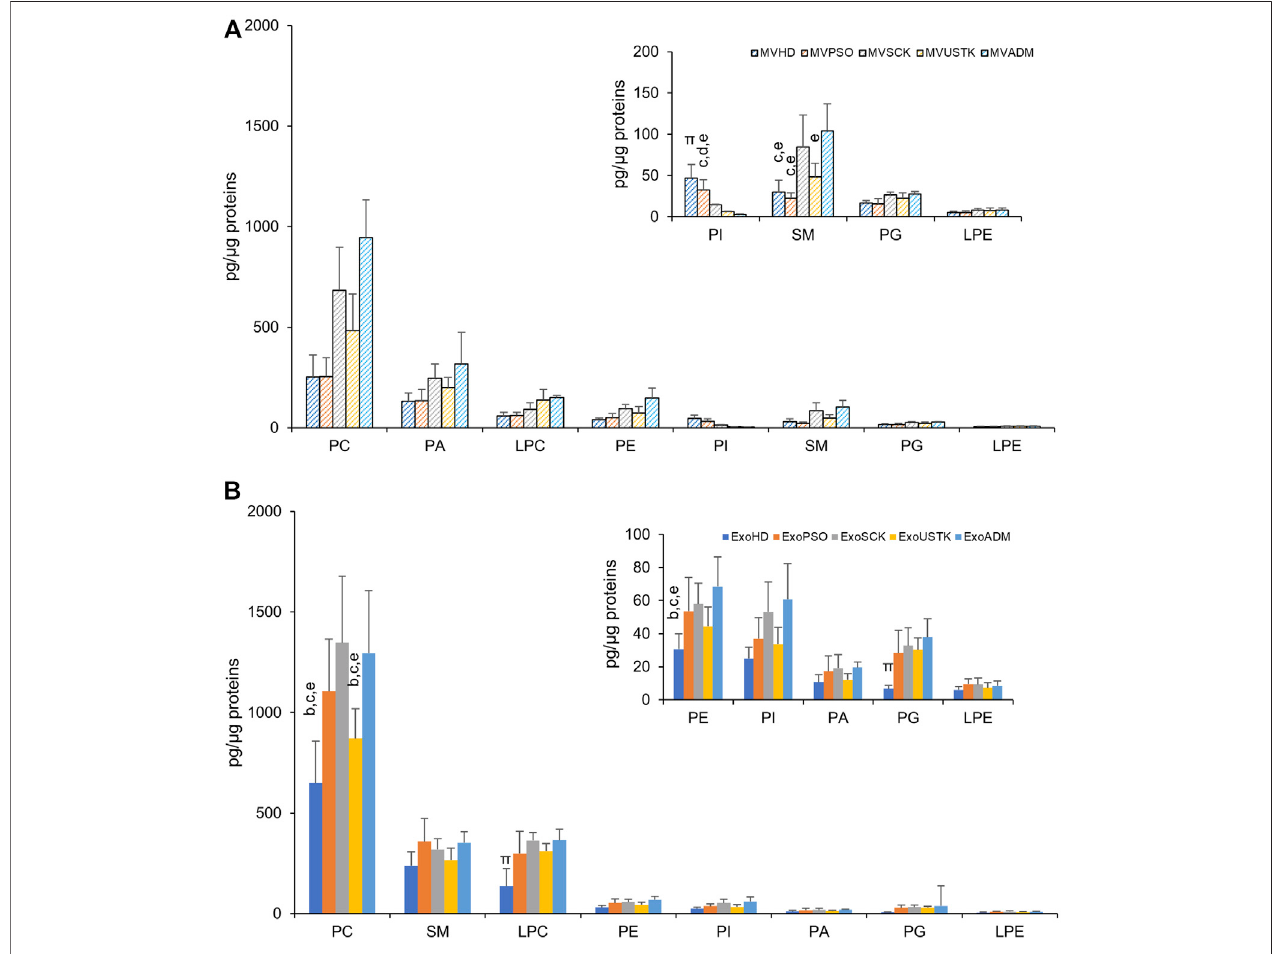
FIGURE3| PhospholipidcompositionofEVsderivedfromplasmaofHD,PSOandPSOtreatedwithSCK,USTKandADM.LipidextractsfromMV (A) andExo (B) were analyzed by LC-MS. The amount of each PL class (sum of all detected species) is expressed as pg of lipids/µg of proteins. Data are reported as mean ± S.D. Statisticallysigni fi cantdifferences ( p < 0.05) resultedbyone-wayANOVAand Tukey ’ spost-hocanalysis;columns withdifferentletters aresigni fi cantlydifferent(i.e. avs. HD, b vs. PSO, c vs. SCK, d vs. USTK, e vs. ADM and π vs. all).